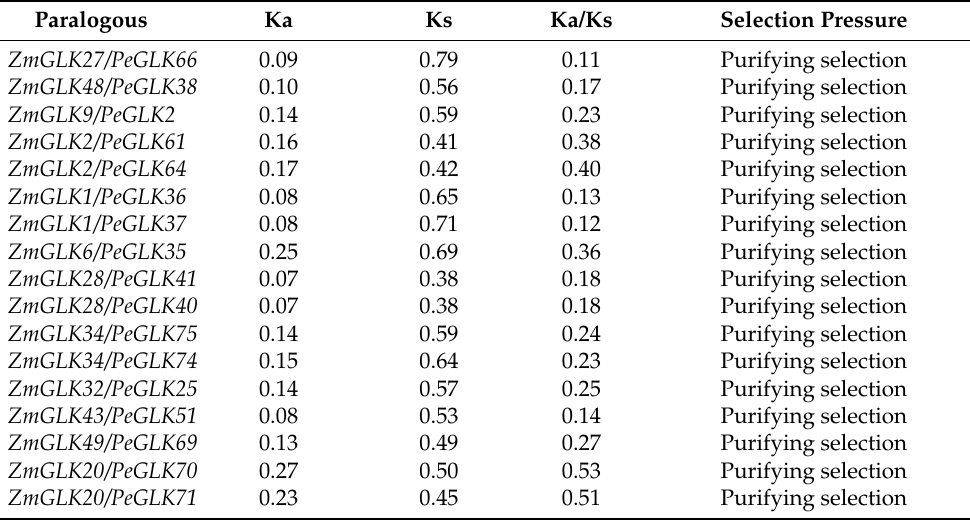
Table 3. Ka/Ks and divergence analysis of orthologous GLK genes in moso bamboo and